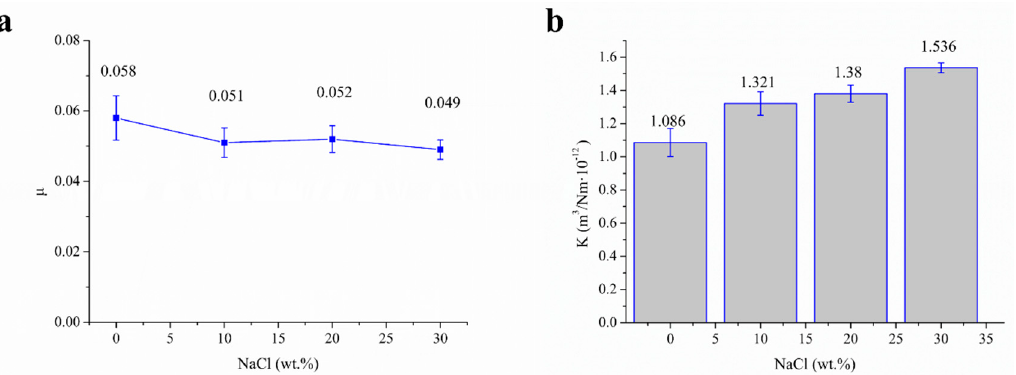
Figure 9. Effect of NaCl contents on tribological properties of UHMWPE and surface porous GO/NaCl/UHMWPE composites with 1% GO in water, ( a ) the coefficient of friction ( µ ), ( b ) wear ratio ( κ ).